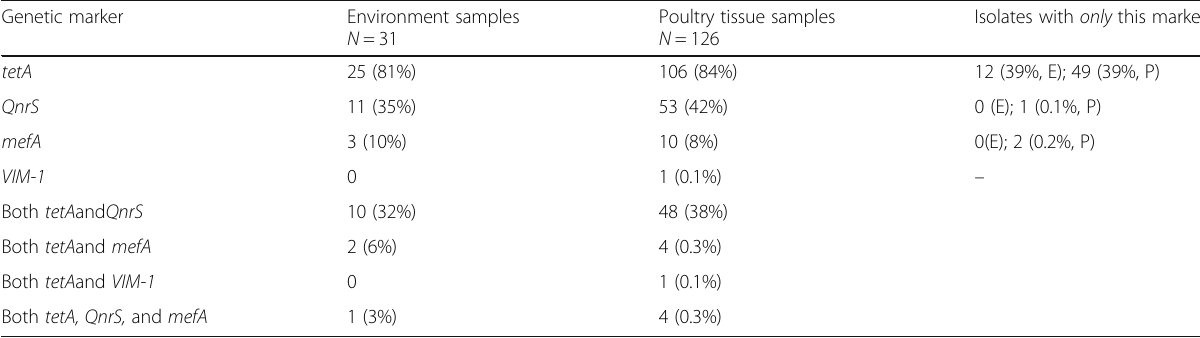
Isolates with only this